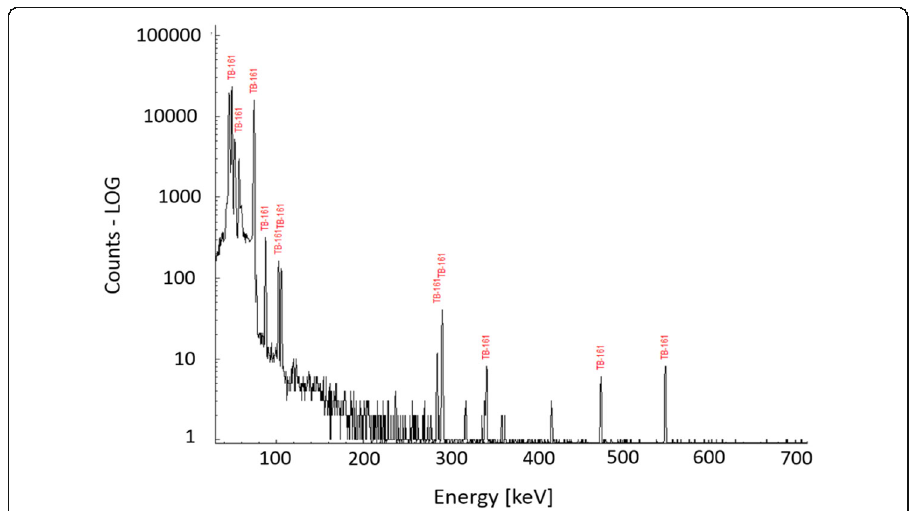
Fig. 3 Gamma spectrum of 161 Tb, obtained after the purification process. The radionuclidic impurity 160 Tb is not visible due to the negligible activity as compared to that of 161 Tb at end of separation (EOS)